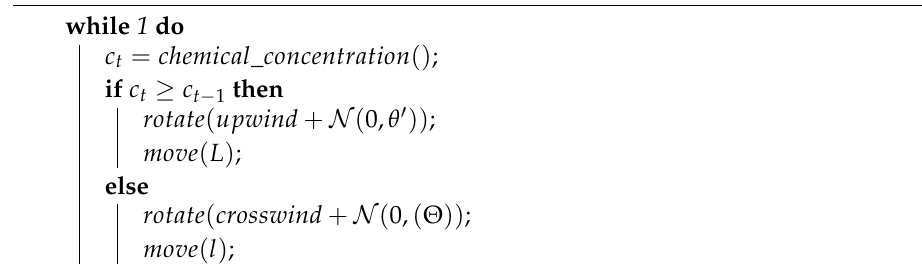
Algorithm 5: Pseudocode of the Anemotactic E. coli